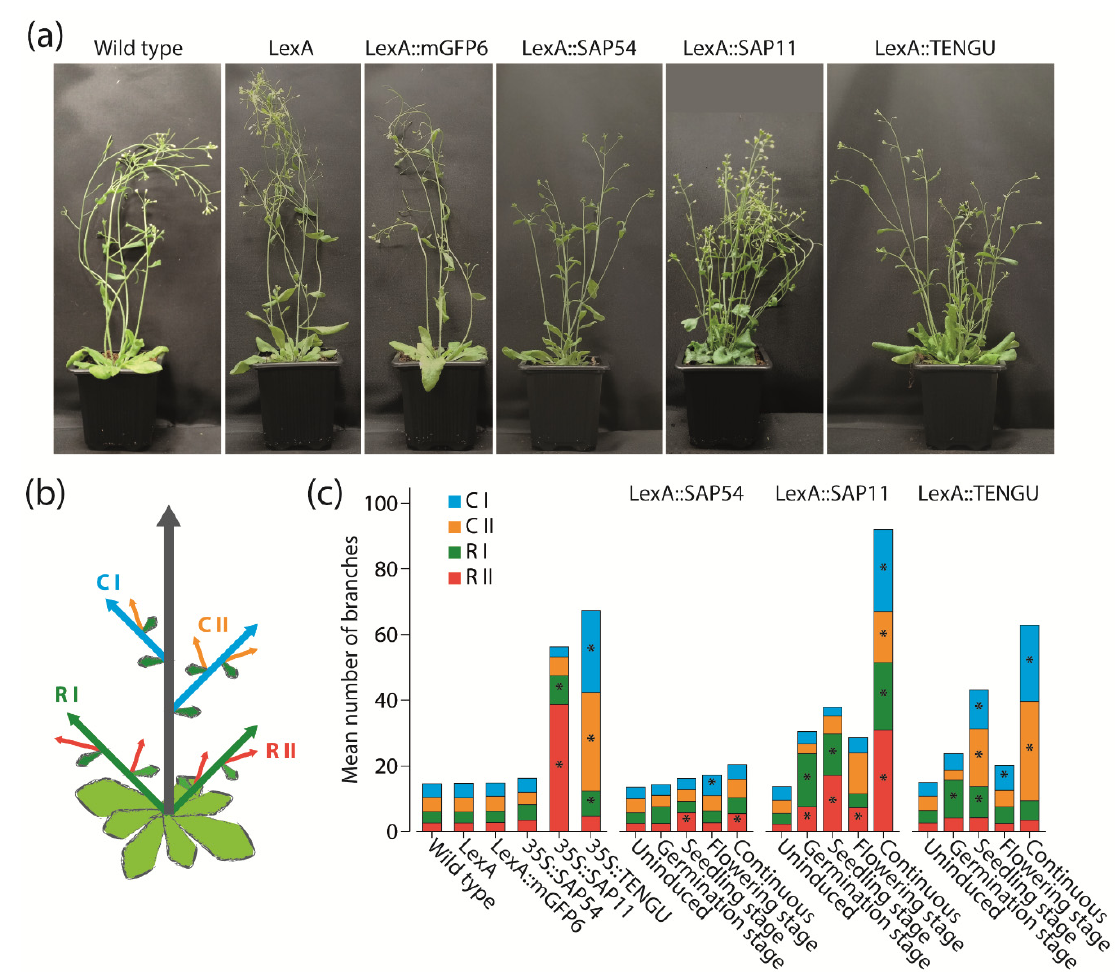
Figure 4. Branching phenotype observed in Arabidopsis upon SAP54, SAP11, and TENGU expression. ( a ) Plant habit of non-transgenic Arabidopsis Col-0 wild type plants, transgenic plants carrying pBb7m34GW-35S::XVE vector with no coding sequence cloned under control of the LexA promoter element (LexA), LexA::mGFP6, LexA::SAP54, LexA::SAP11, and LexA::TENGU plants that were grown on IM for 28 d (continuous induction). ( b ) Scheme illustrating shoot branch orders of Arabidopsis with the main shoot (grey arrow), primary rosette branches (R I, green arrows), secondary rosette branches (R II, red arrows), primary cauline branches (C I, blue arrows), and secondary cauline branches (C II, orange arrows). ( c ) Number of primary and secondary rosette and cauline branches of effector protein expressing plants and control lines counted 28 DAS. LexA::SAP54, LexA::SAP11, and LexA::TENGU plants were either grown on NM throughout (uninduced), or induced following the induction regimes illustrated in Figure 2. Arabidopsis wild type plants, LexA, LexA::mGFP6, 35S::SAP54, 35S::SAP11, and 35S::TENGU plants were grown on IM throughout. Branch numbers significantly differing from wild type values are indicated by an asterisk (Kruskal–Wallis test followed by pairwise Mann–Whitney U tests, Bonferroni corrected, * p ≤ 0.05, n = 10–20). As can be seen in the plant habit images in panel ( a ), some effector protein expressing plants additionally displayed rosette leaf alterations, such as leaf roll and curly/crinkled leaves.